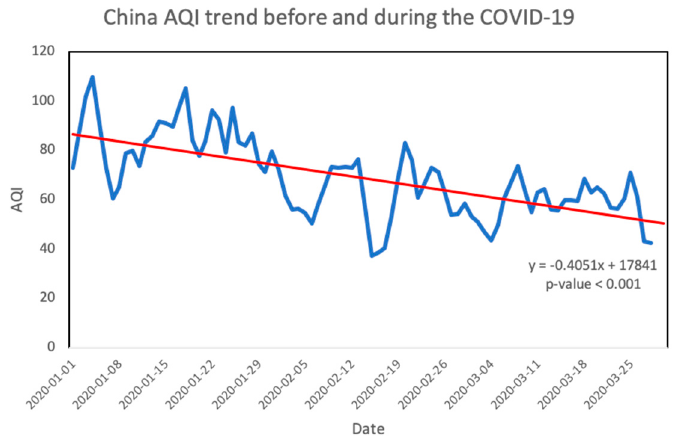
Figure 6. Daily average AQI time series of China from January 1, 2020 to March 26, 2020.